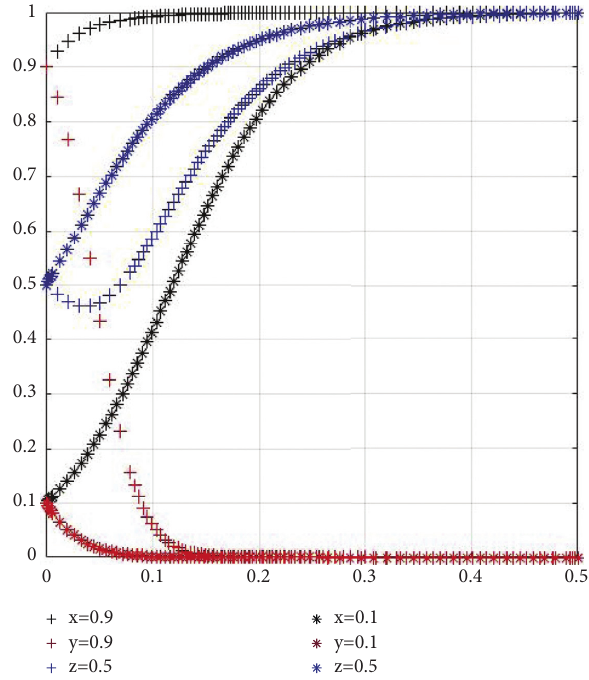
Figure 5: Participation willingness x remains unchanged, while y and z change simultaneously ( y � z � 0.1 ⟶ y � z � 0.9).